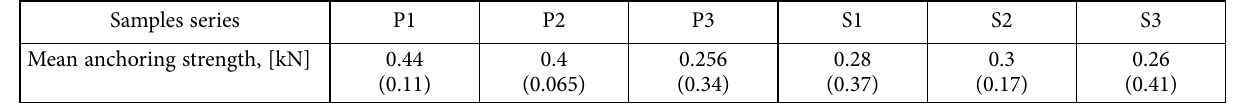
Table 2. Results of flexible ties